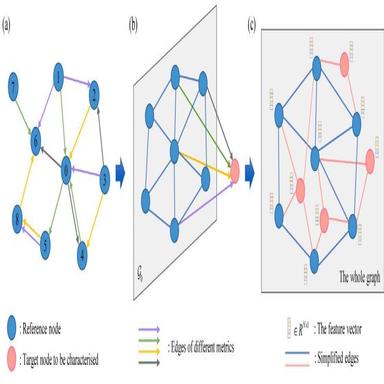
The proposed DGAT-NS model.